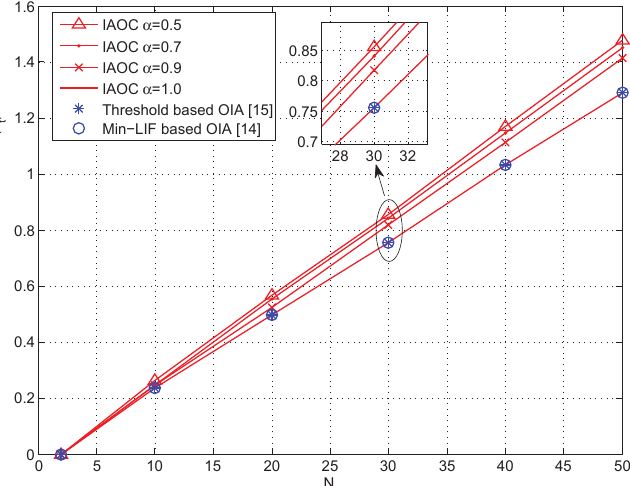
Figure 6. The total harvested power versus N . K = 4, N r = 4, N t = 2, S =